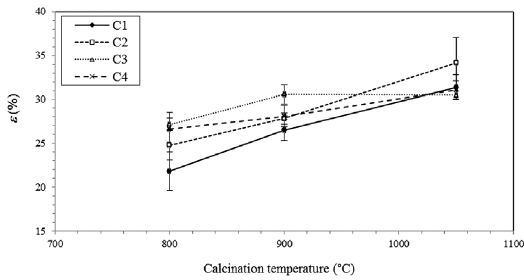
Figure 4. Porosity of compositions C-2 and C-4 as a function of the